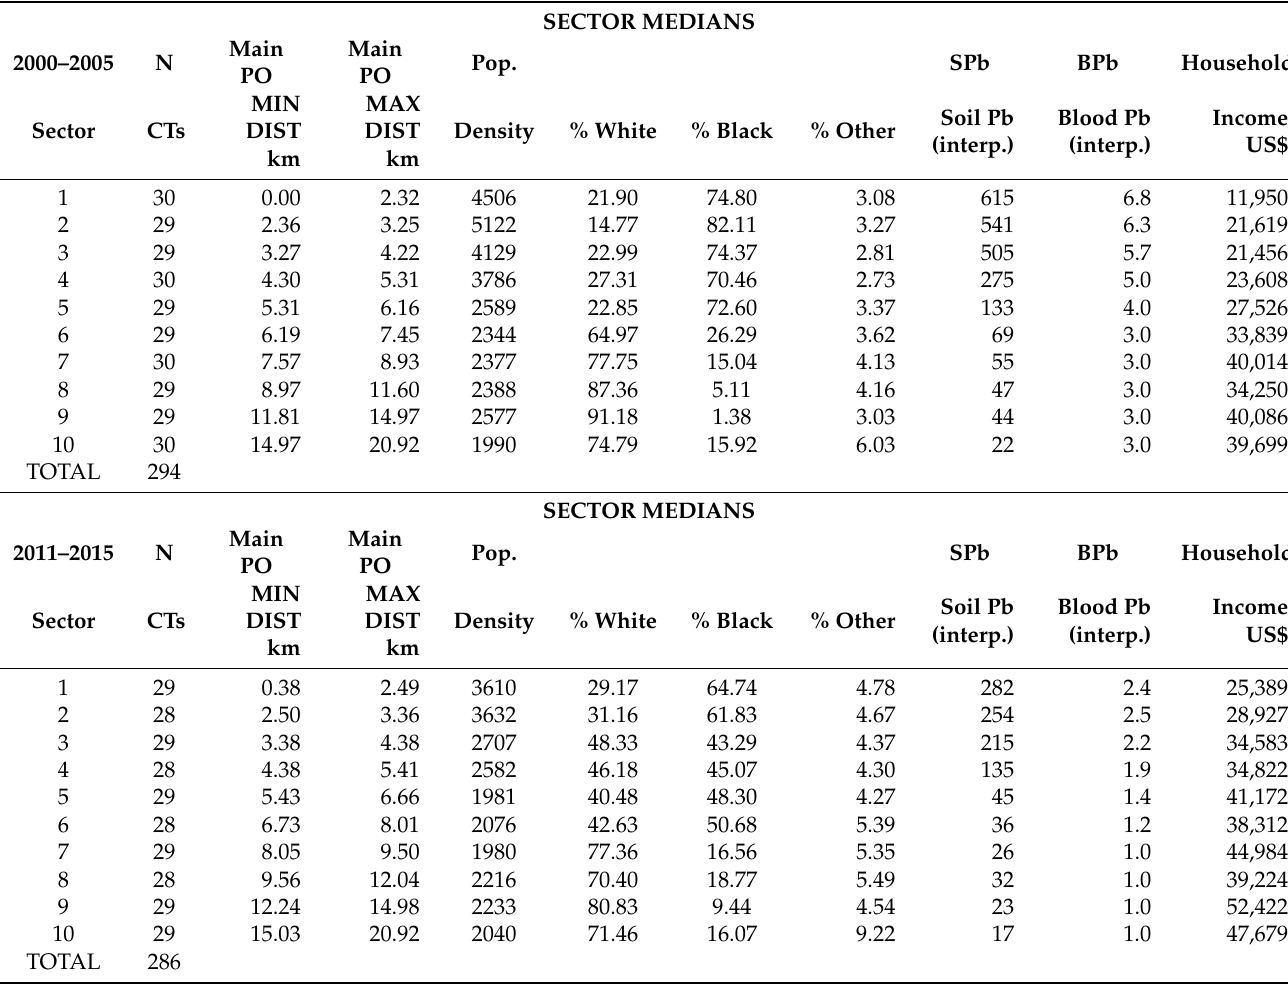
Table 2. New Orleans Census tract characteristics, soil Pb (SPb), and children’s blood Pb (BPb) are divided into 10 distance sectors from the Main Post Office (PO). The population density is inhabitants per square kilometer. The interpolated values for SPb, BPb, and household income are also